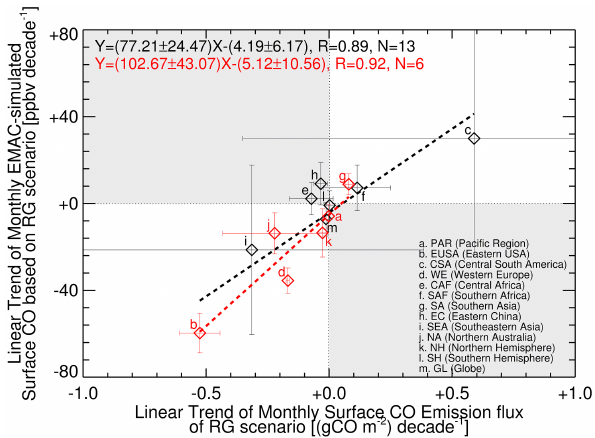
Figure 11. Comparisons of the trends of monthly RG CO emission flux against the trend of monthly EMAC-simulated surface CO with ± 2 σ errors for the selected regions listed oin Table 1. Black and red fonts indicate the results of the comparison between all avail- able trends and of the comparison between significant trends only,